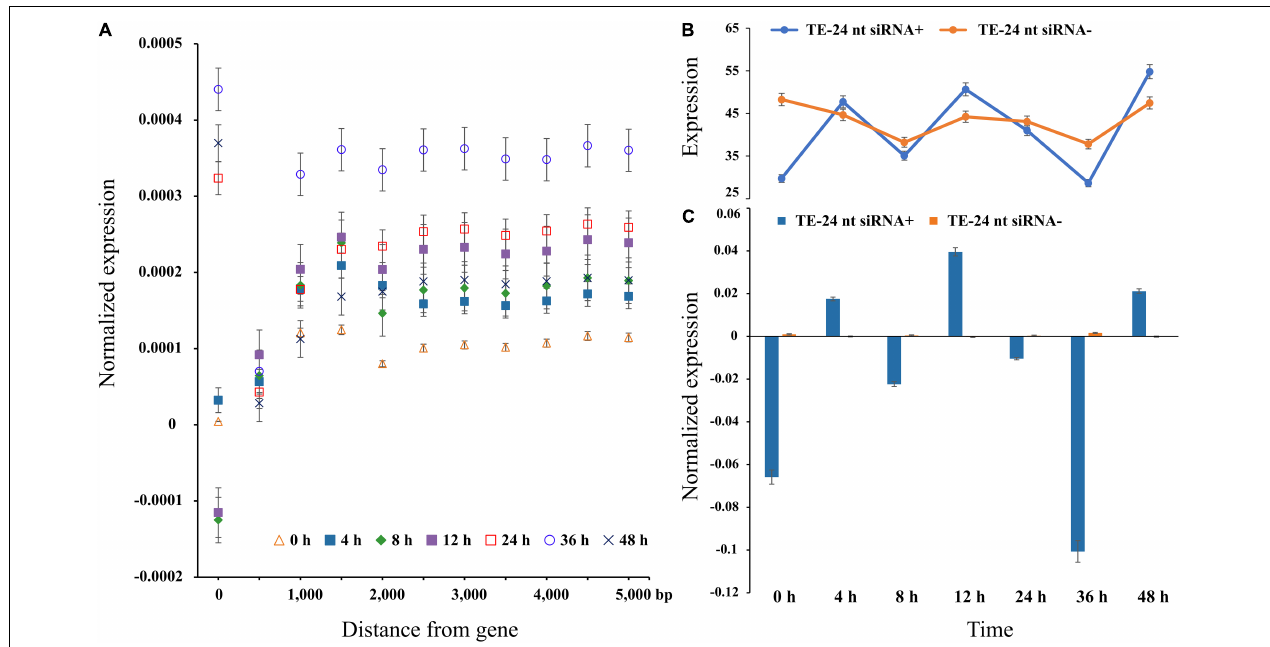
FIGURE 2 | Gene expression level in each bin farther away from the nearest TE in P. trichocarpa. (A) The average value of gene expression was TE distance, with 500-bp bin and max to 5000-bp. A distance of zero indicates TEs in intron or UTRs. (B,C) Gene expression levels of TEs (distances binned in 1000-bp) with and without matching 24-nt